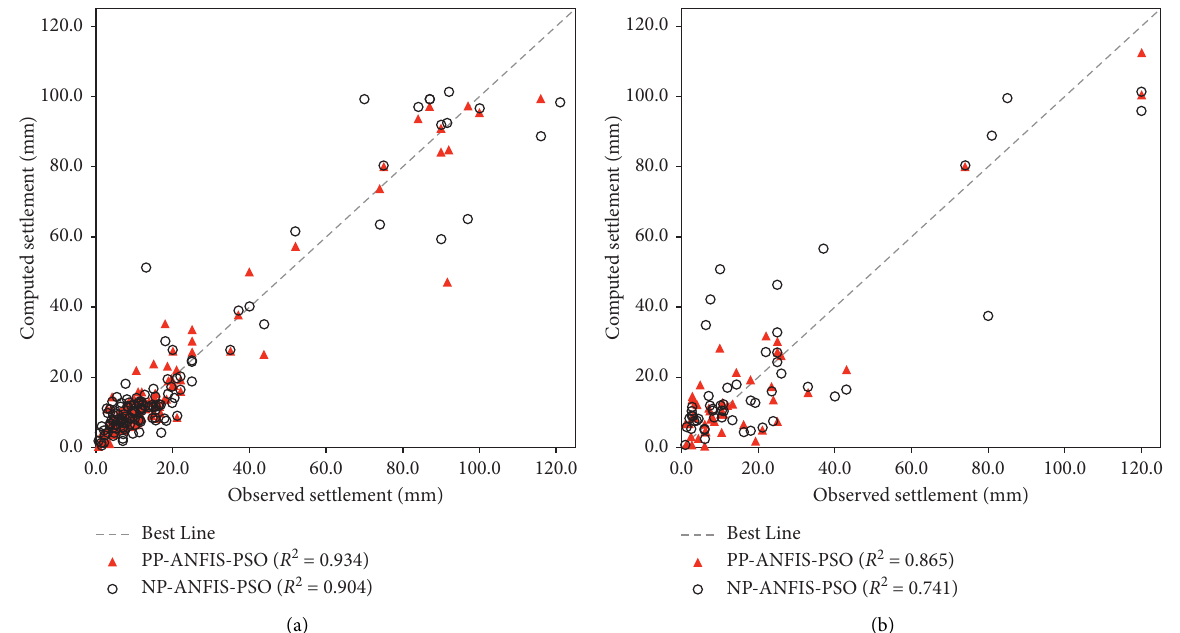
Figure 6: The scatter plot presentation between the observed settlement measurement and predicted values using the accurate hybrid intelligence (i.e., ANFIS-PSO) (both modeling scenarios): (a) training phase and (b) testing phase.